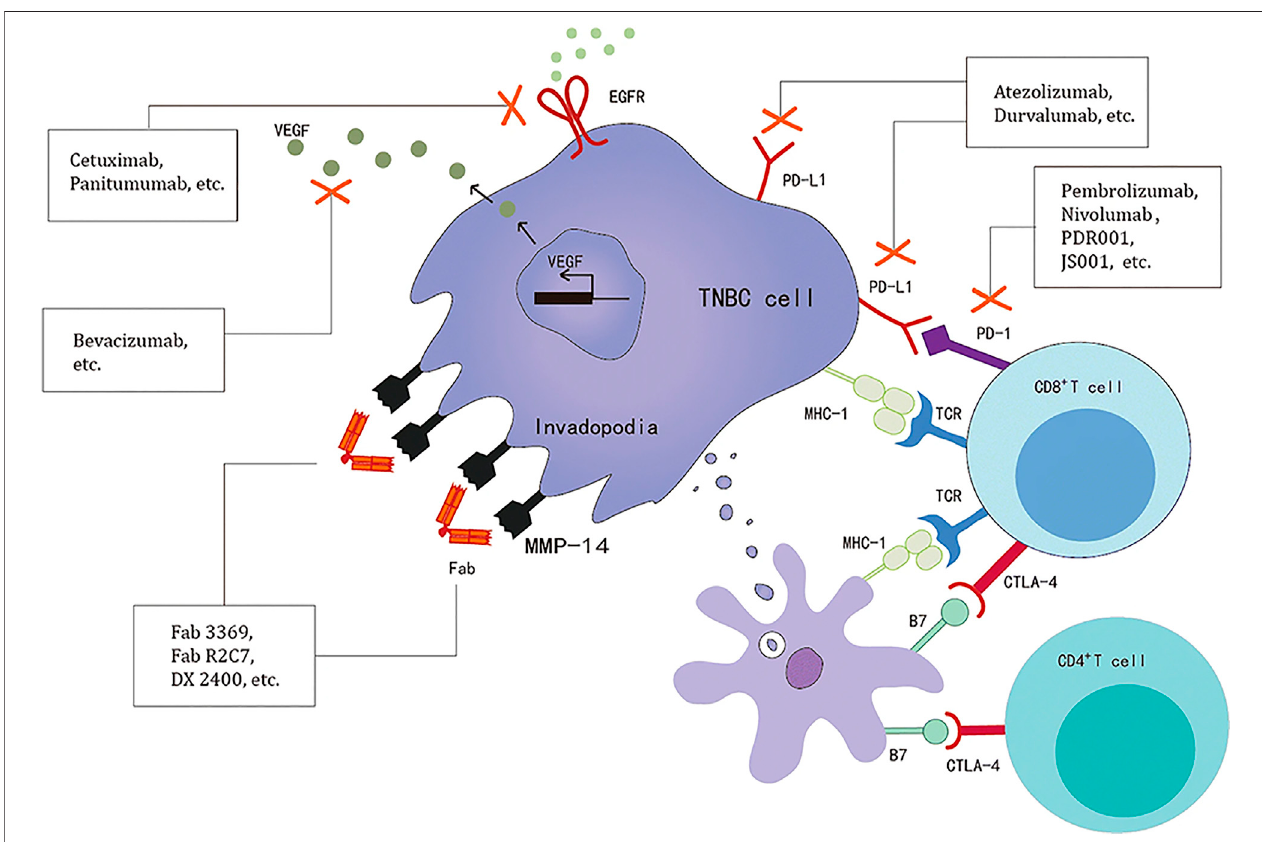
FIGURE 1 | TNBC-related immune drug targets (Li et al.,